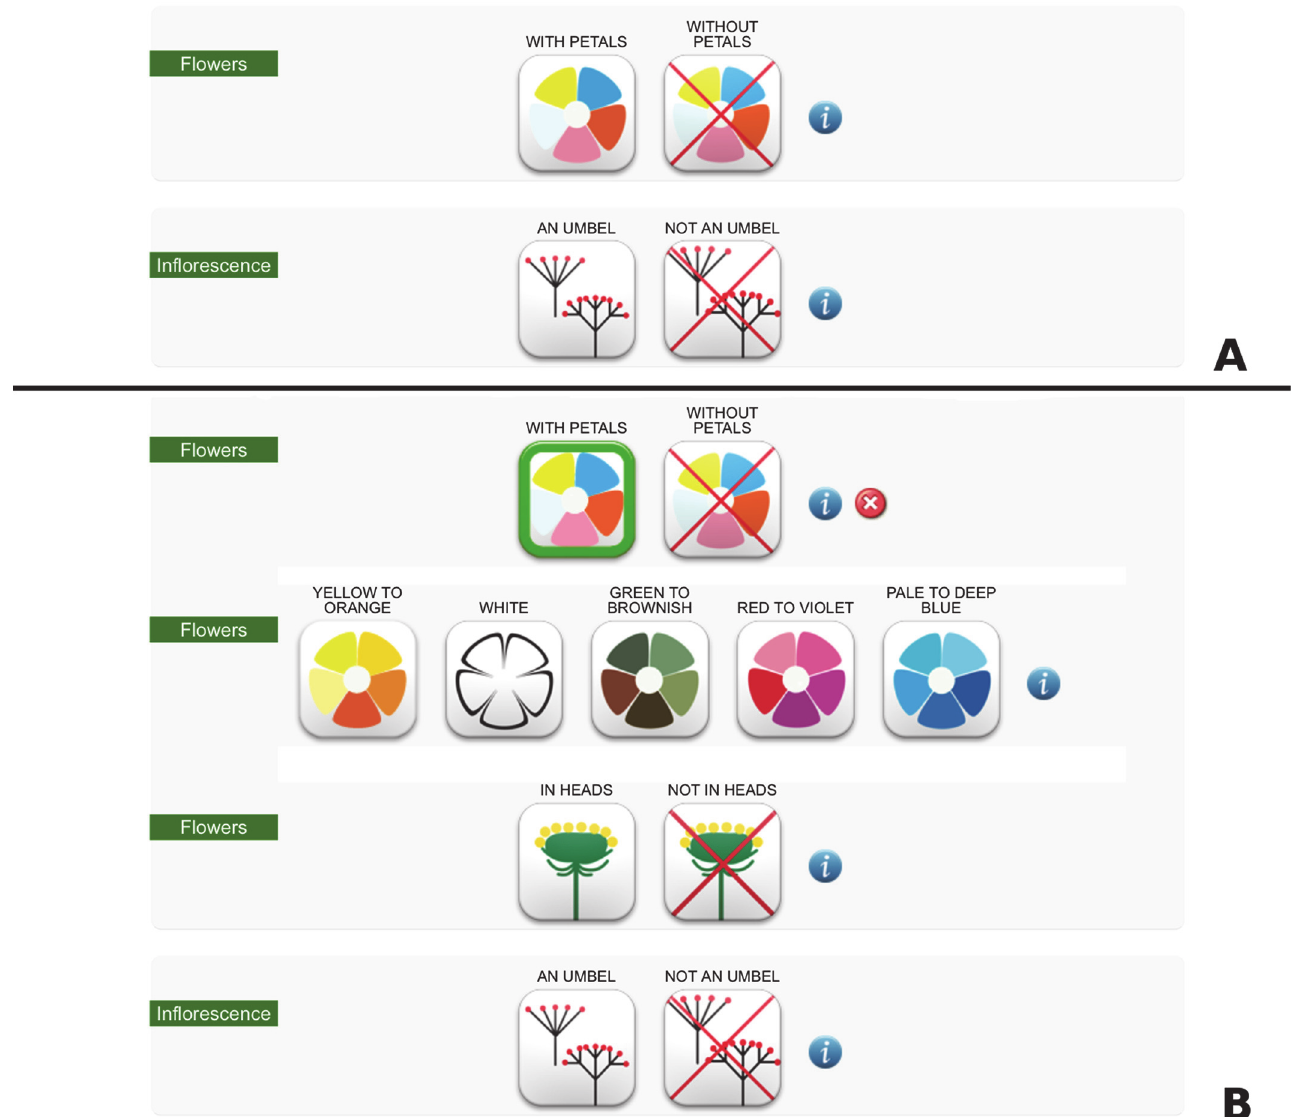
Fig 6. Some of the characters become accessible only when specific character states are selected. When selecting the state “ with petals ” for the character “ Flowers ” (a), the character "colour of petals" becomes usable